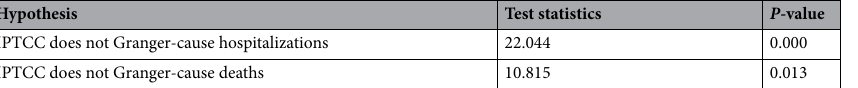
Table 1. Granger causality from the IPTCC to hospitalizations and deaths. The test statistic is a Wald statistic which follows, under the null hypothesis, a chi-squared distribution of 3 (the number of constraints that corresponds to the lag